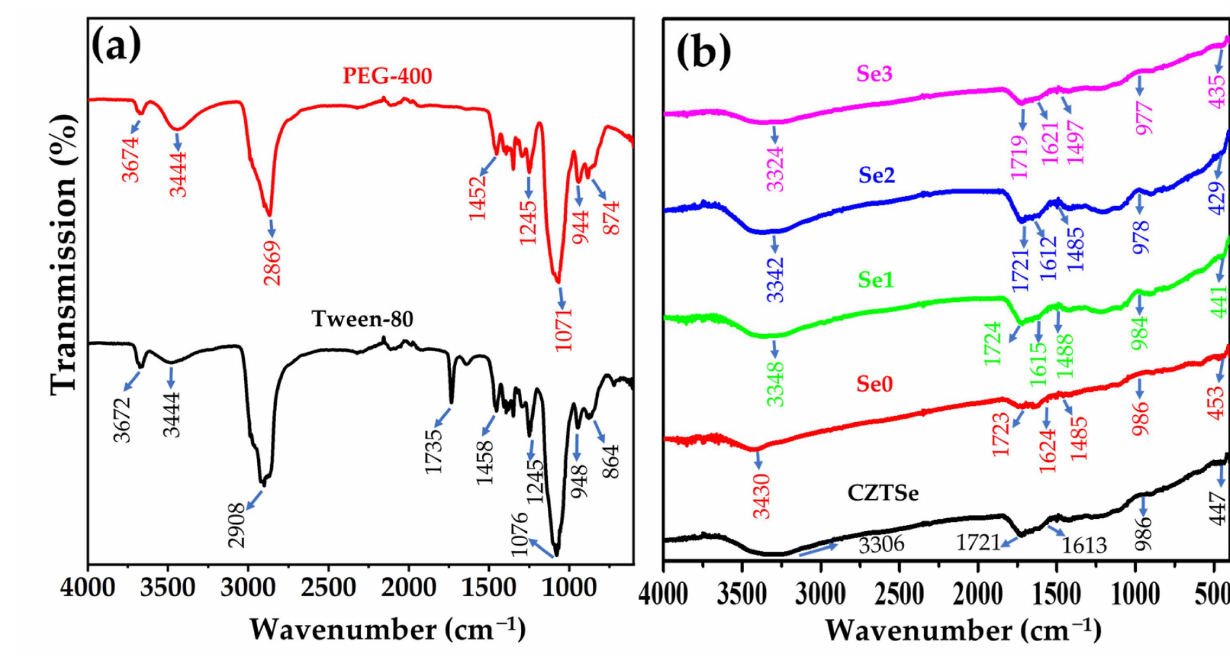
Figure 4. FT-IR spectra of ( a ) Tween-80 and PEG-400, and ( b ) CZTSe thin films. The FT-IR peaks in a similar region were observed for Se2 and Se3 at wave numbers of approximately 3300, 1700, 1600, and 984 cm − 1 , and these observed peaks are well- match with the unannealed samples. A weak vibrational band of metal selenide was observed in the spectrum at 550–400 cm − 1 in the as-synthesized Se2 and Se3 samples